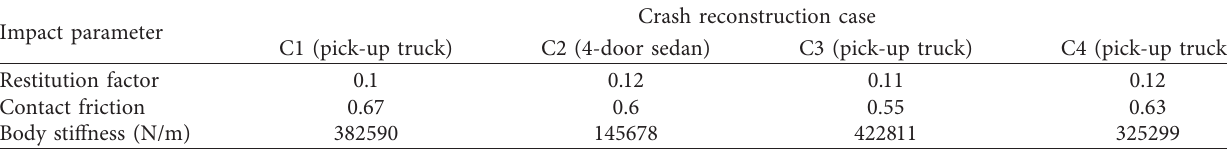
Table 8: Summary of parameters resulted from the crash reconstruction.